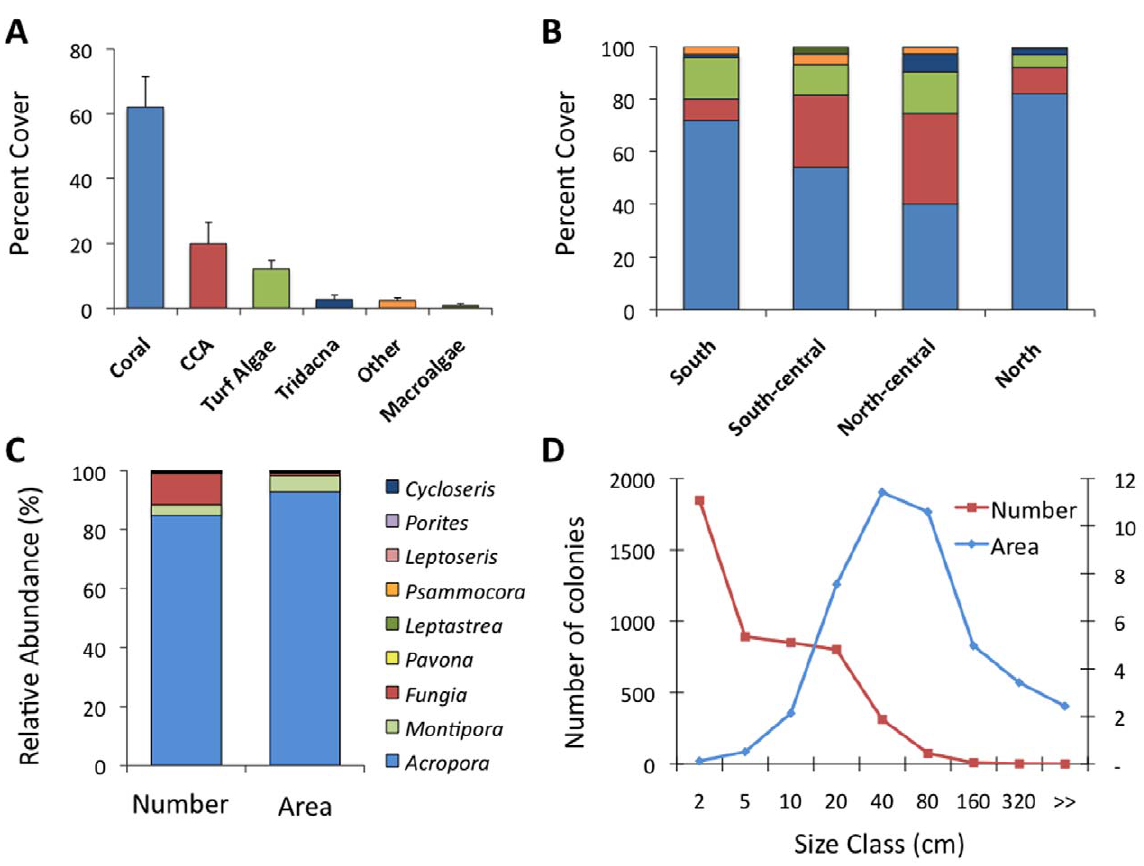
Figure 2. Results of benthic surveys. A) Substrate cover of line reefs in Millenium lagoon (mean 6 1 standard error). B) Relative percent cover of line reefs by region. C) Relative abundance of coral genera, by number of colonies and percent area cover. D) Size class distributions of corals. The horizontal axis indicates the upper limits of size class.